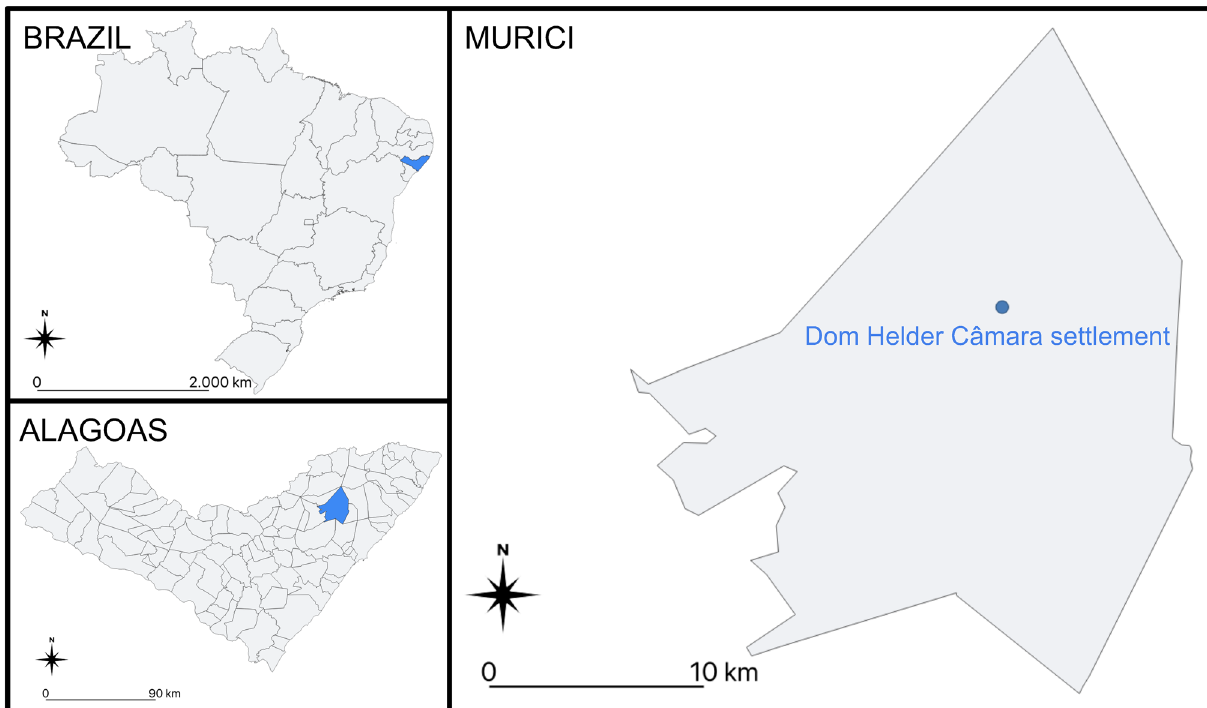
Figure 1. Location of the Dom Helder Câmara rural settlement, in the municipality of Murici, state of Alagoas, northeastern